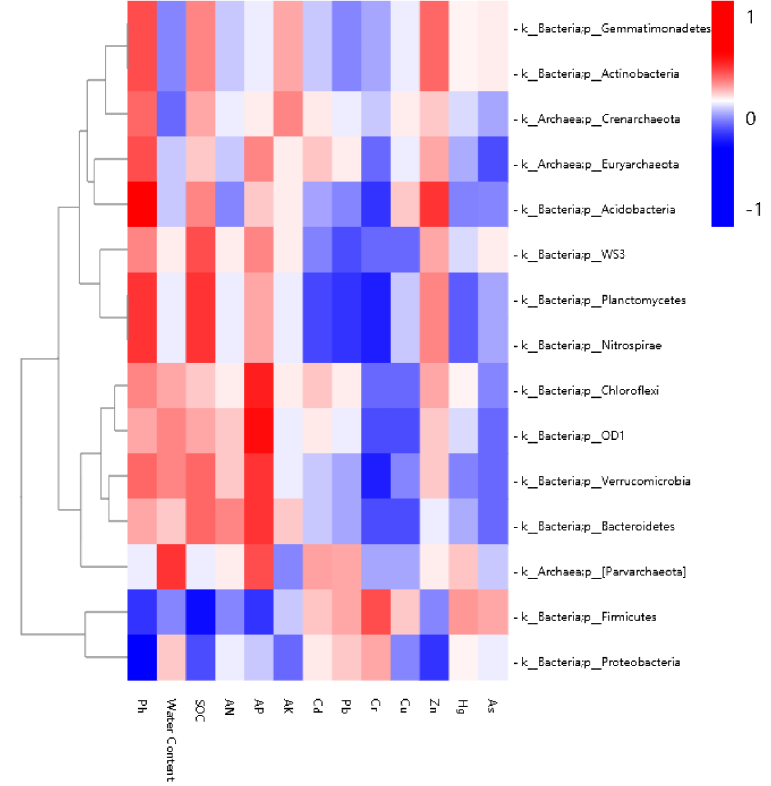
Figure 5. Heatmap of Kendall’s tau-b correlation between the relative abundance of series of bacteria phyla and physicochemical